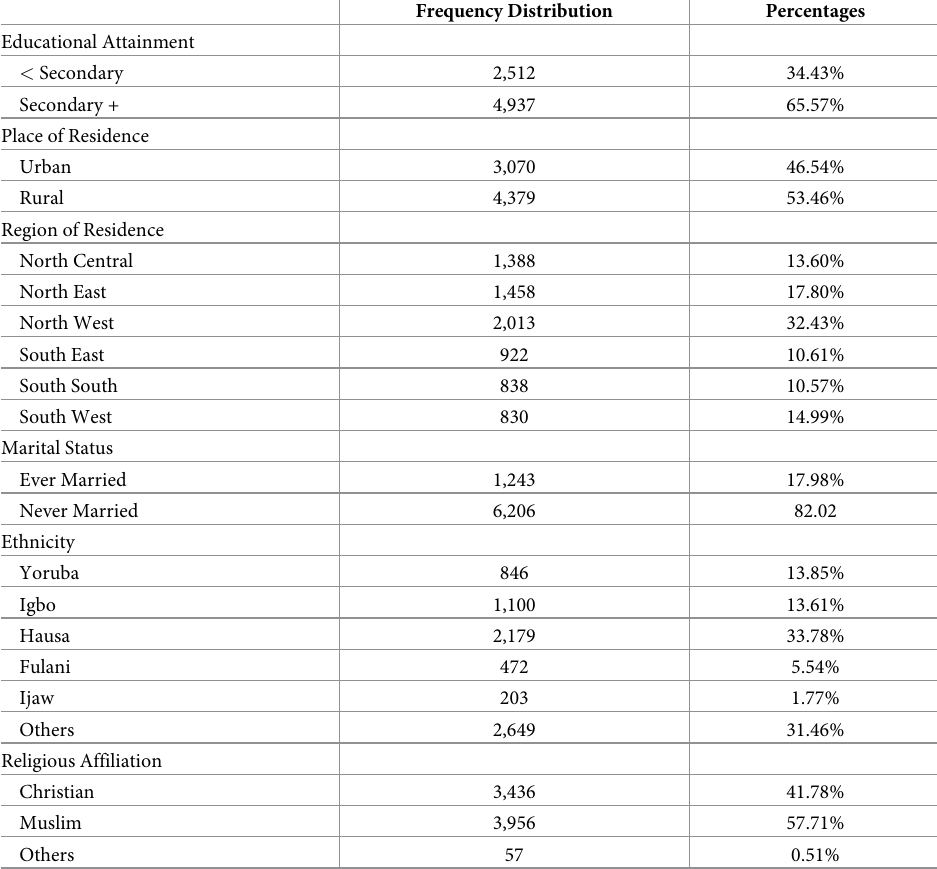
Table 1. Descriptive characteristics of adolescents girls in the